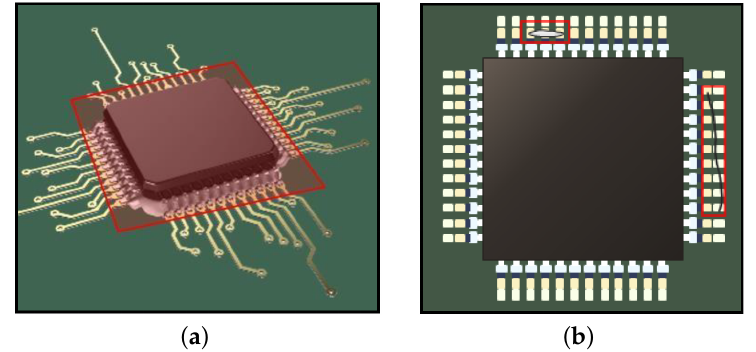
Figure 5. Examples of partial defects on a product. ( a ) Side view: red shaped area denotes ROI. The system finds defects in the ROI. ( b ) Top view: red boxes denote detected defects: abnormal short circuit and hair.